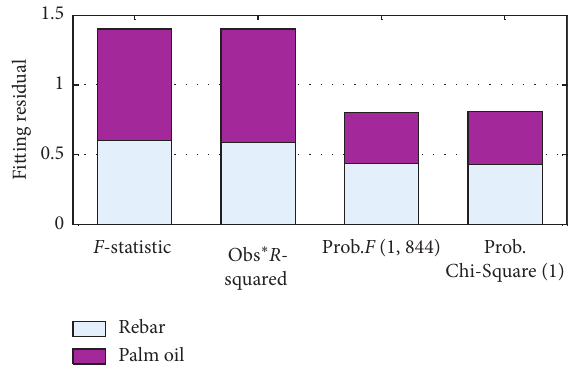
Figure 8: ARCH LM test results of the volatility fitting residuals of the rebar and palm oil price change